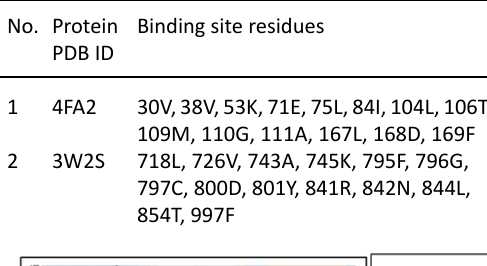
table 1. The details of amino acid residues of both 4FA2 and 3W2S